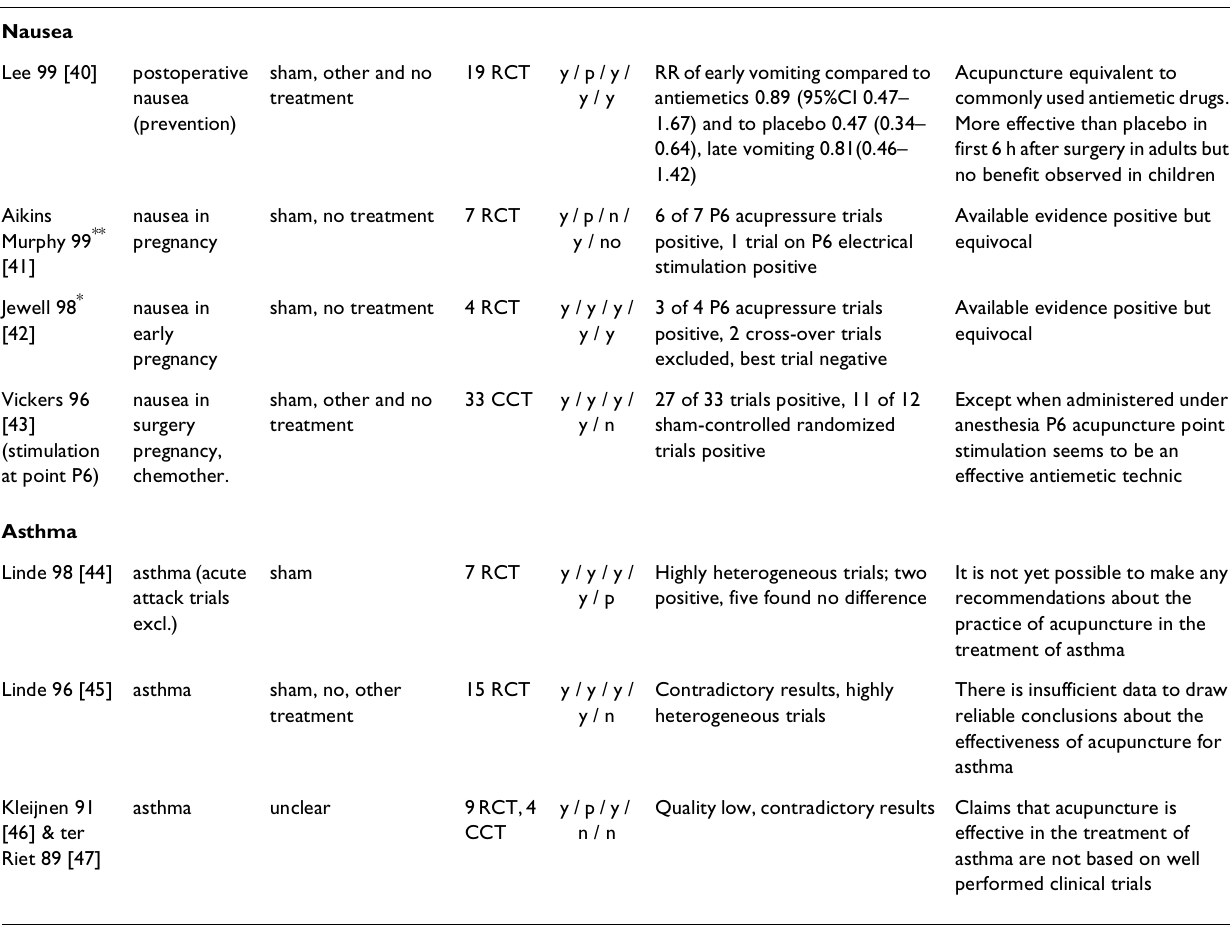
Table 2: Systematic reviews of clinical trials of acupuncture & acupressure in rheumatic diseases, addiction, nausea and asthma